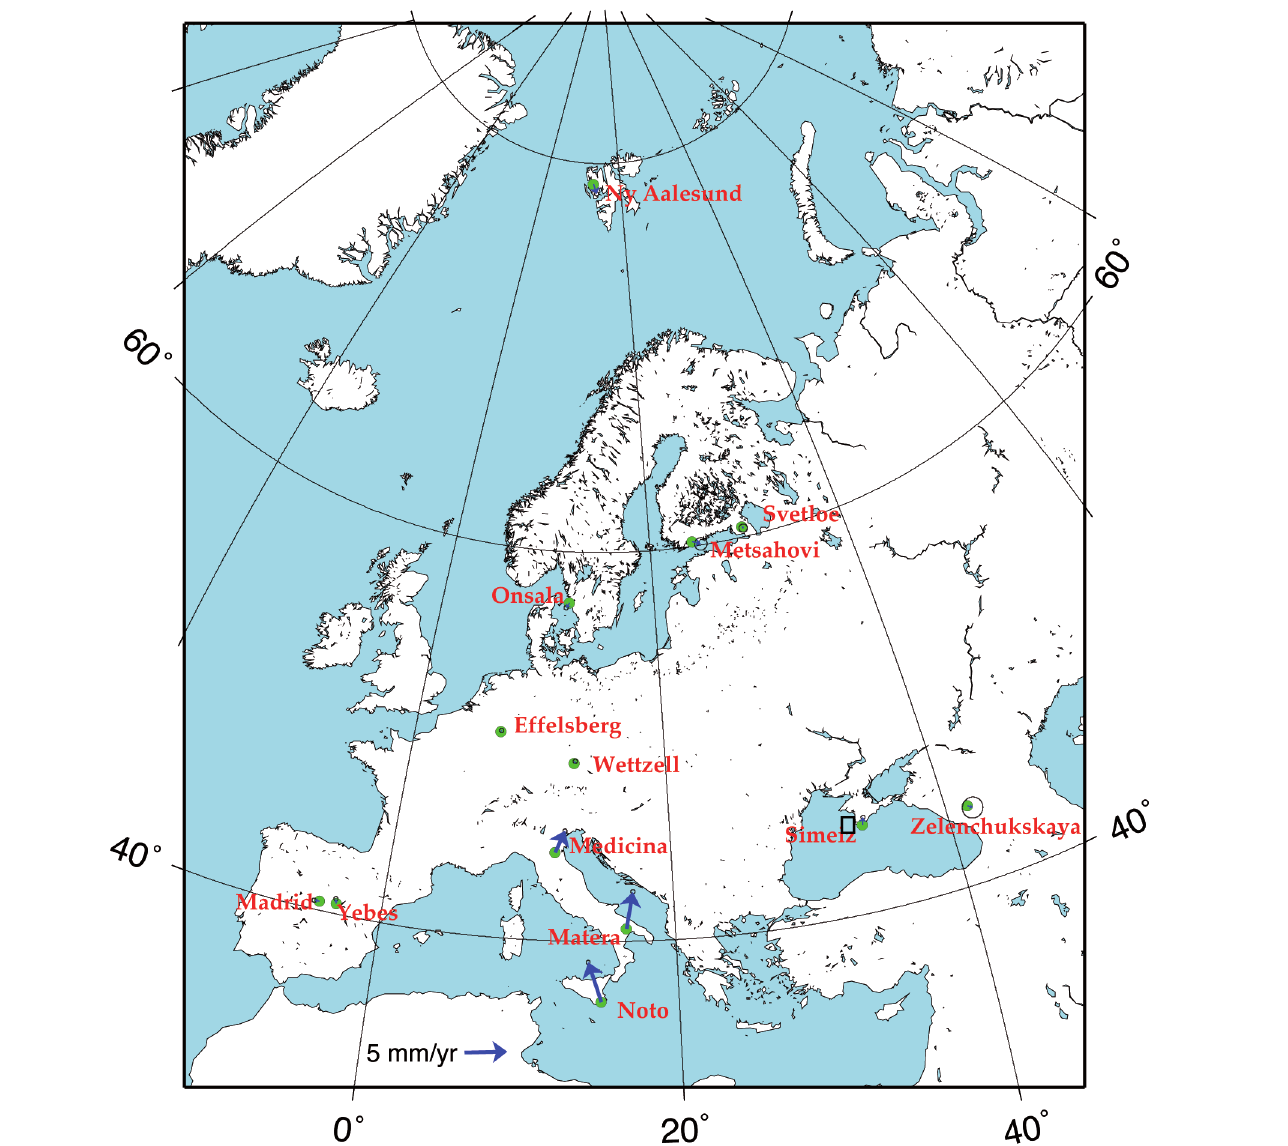
Figure 3. Horizontal velocities of the European sites obtained from the G solution and expressed in the corresponding local topocentric frames. The velocities are relative to the ITRF2005 Eurasian plate motion: the Euler pole location and its rotation rate [Altamimi et al. 2007] have been subtracted from the estimated velocities to derive relative deformation rates at each site. The corresponding values are in Table 1, columns 9 and